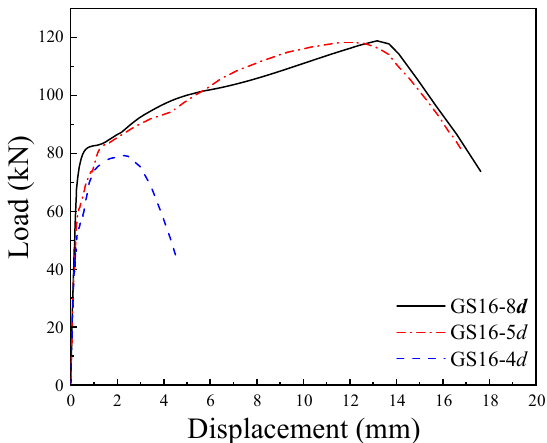
Figure 12. Load–displacement of specimens with different anchorage lengths and without grouting defects. ing